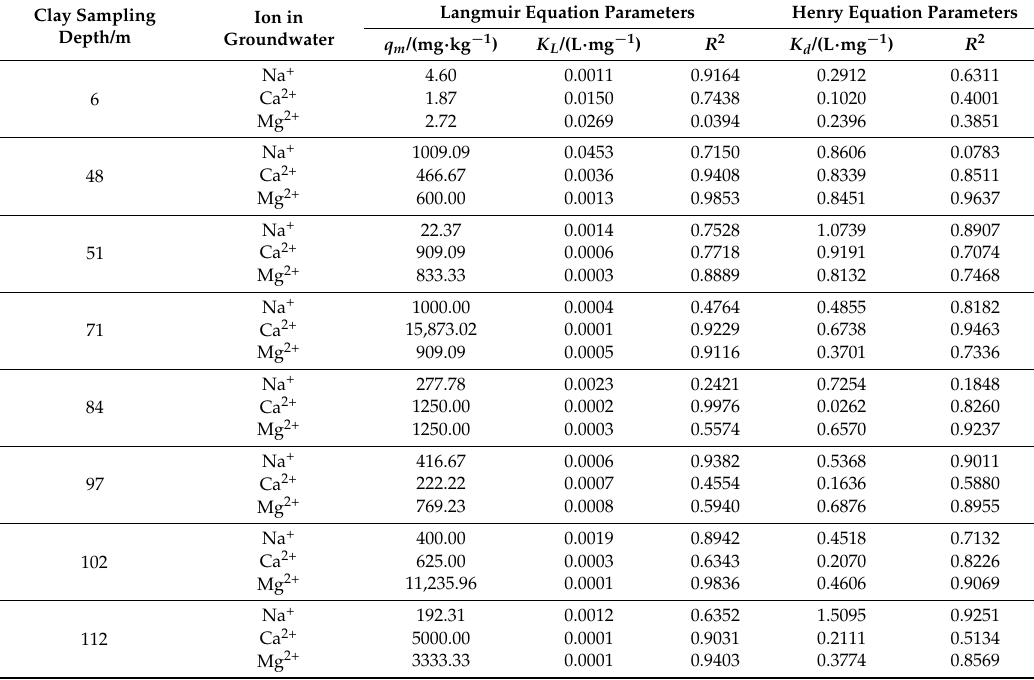
Table 6. The adsorption isotherm model parameters of clay for Na + , Ca 2+ , Mg 2+ in groundwater. Clay Sampling